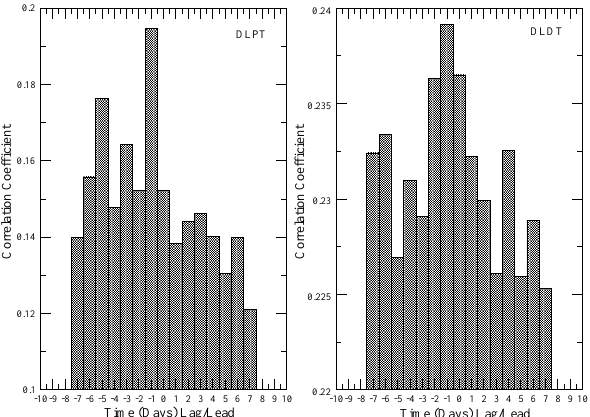
Fig. 7. The cross-correlations between the DLPT (a) or DLDT (b) with the effective earthquake magnitude occurs are plotted as a function of days before and after the event (“0”th day). In (a), the peak occurs one day prior to the seismic event but the effect contin- ues even after the event. In (b), the peak is fairly broad, and appears at around 0.5–1day prior to the event.